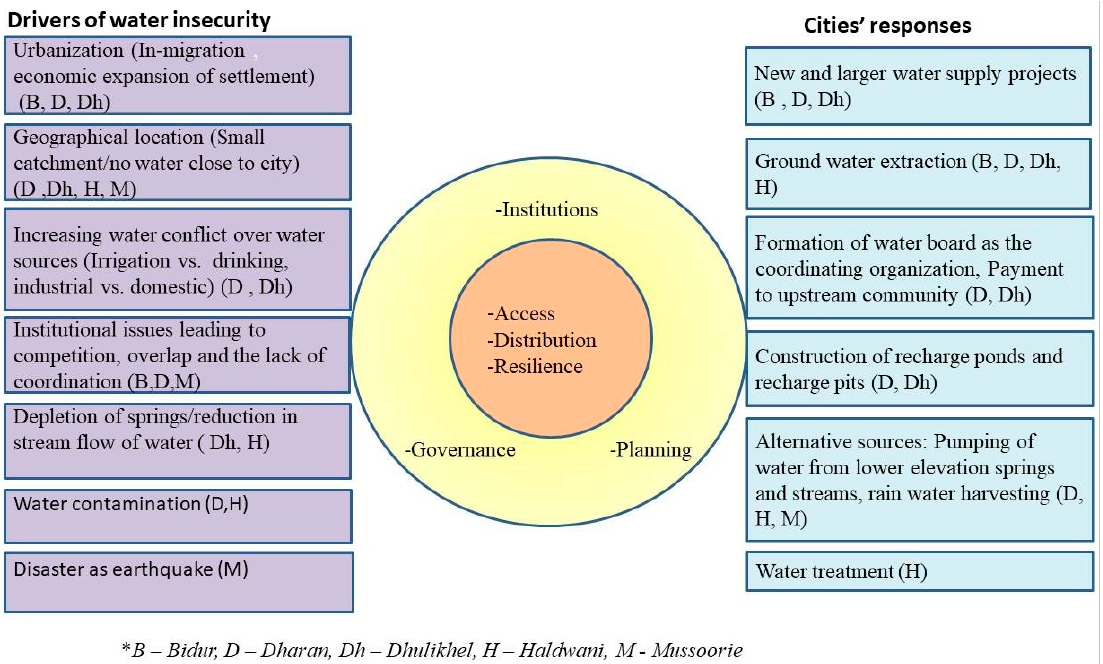
Figure 8. A synthesis of drivers of water insecurity and cities’ responses in the five case study cities.